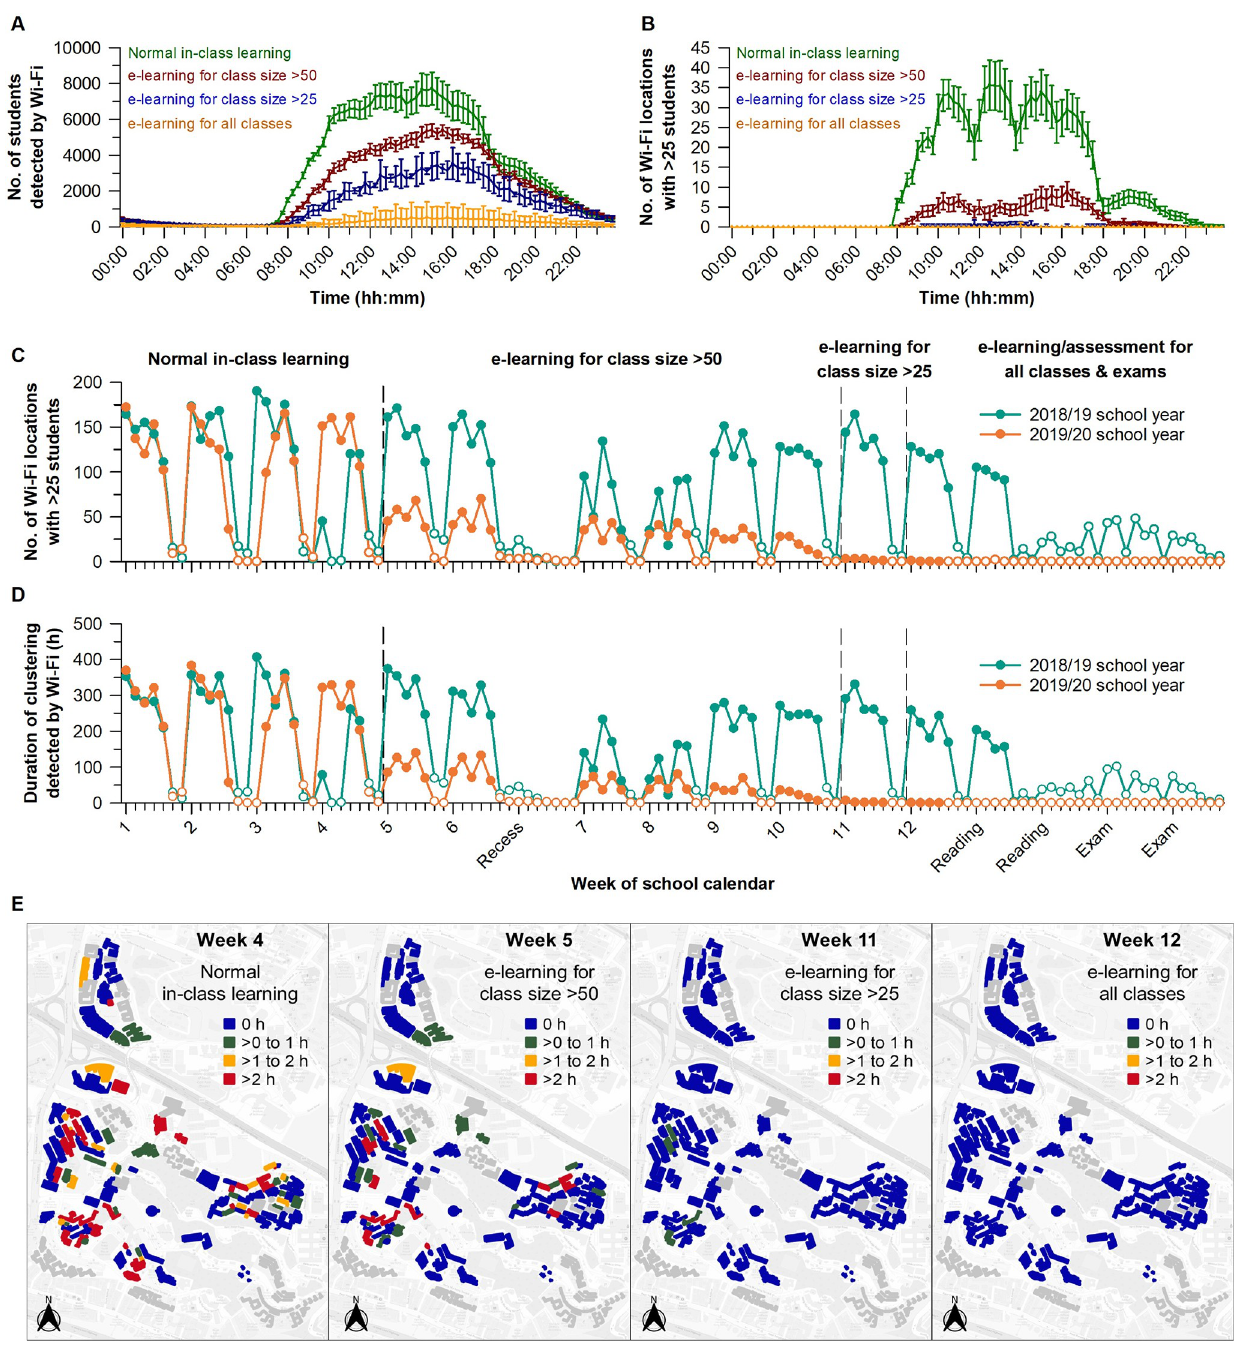
Fig 2. E-learning interventions reduced student clustering during the COVID-19 outbreak. Each e-learning intervention was associated with ( A ) a decrease in the daily rhythm in students detected on campus, and ( B ) a flattening in the daily time course of locations with > 25 students connected to the same Wi-Fi access point. E-learning measures during the disease outbreak (2019/20 school year) were effective at decreasing ( C ) the daily number of Wi-Fi locations with a student cluster, and ( D ) the duration of clustering at these sites, as compared with the prior academic year with normal in-class learning (2018/19 school year). ( E ) The daily duration of student clustering in campus buildings decreased as more stringent e-learning policies were implemented. In panels A and B , the daily mean ± 95% CI is shown for different parts of the semester. In panels C and D , open circles indicate non-class days. In panel E , buildings are colour-coded by the daily average of clustering duration. Buildings with missing or incomplete Wi-Fi data are coloured grey.